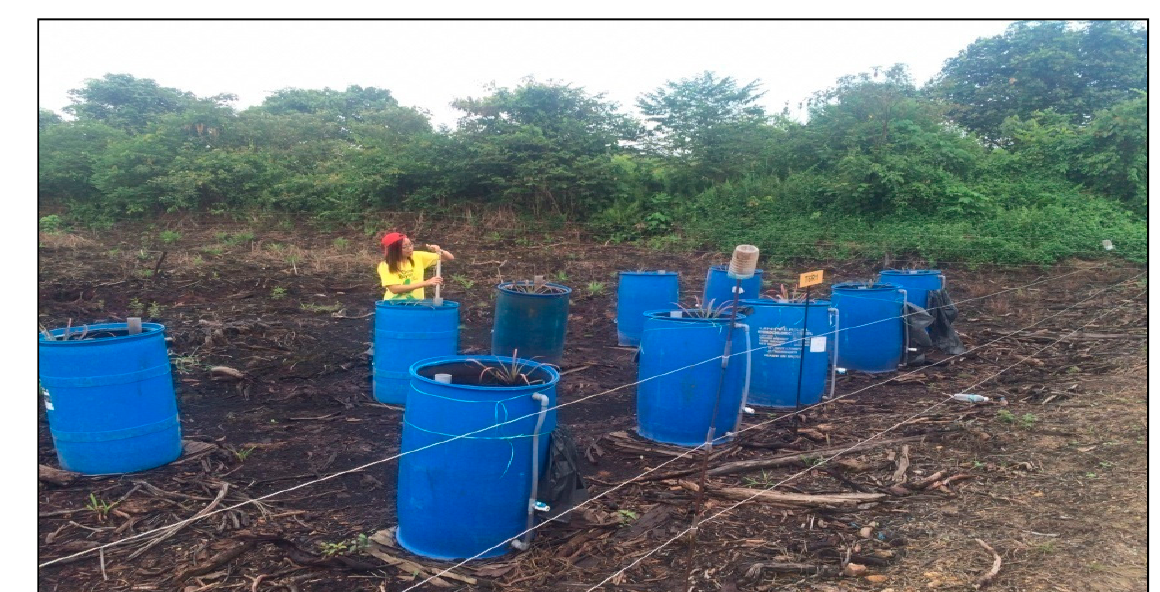
Figure 3. Fabricated field lysimeter made from high density polyethylene.